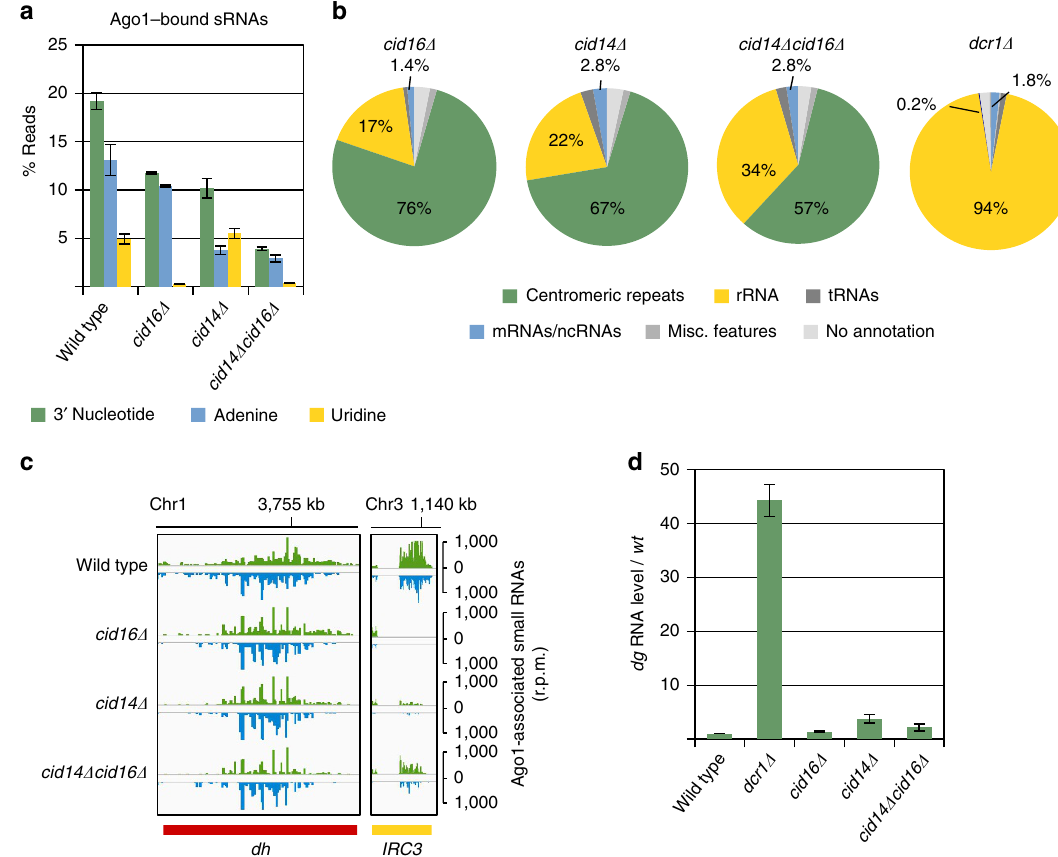
Figure 2 | Cid14 adenylates and Cid16 uridylates the 3 0 end of Argonaute-bound sRNAs. ( a ) Quantification of Argonaute-bound sRNAs that have non- templated nucleotides at the 3 0 end in indicated strains. Error bars indicate s.e.m. of two independent sRNA-sequencing experiments. Cid14 adenylates and Cid16 uridylates the 3 0 end of sRNAs. ( b ) Argonaute-bound sRNAs were analysed by high-throughput sequencing from indicated cells and classified as indicated below the pie charts. Pie charts illustrate percentages for the individual sRNA classes relative to the total number of reads for each strain. ( c ) Argonaute-bound sRNA reads from indicated cells were plotted over centromeric region. The location of genes is indicated below the sRNA peaks. Reads from þ and (cid:2) strands are depicted in green and blue, respectively. Scale bars on the right denote sRNA reads numbers normalized per one million reads. ( d ) Quantification of centromeric dg transcripts in indicated strains by RT-qPCR. In cid14 D and cid14 D cid16 D cells dg RNA is accumulating. Error bars indicate s.e.m. of 4 six independent experiments. ‘/’ indicates fold